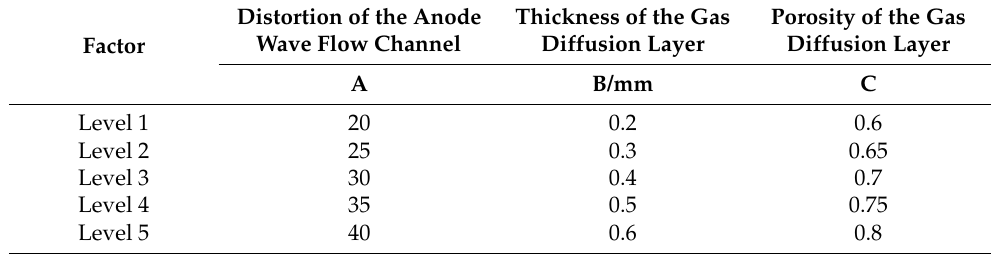
Table 3. Orthogonal experimental factor level.